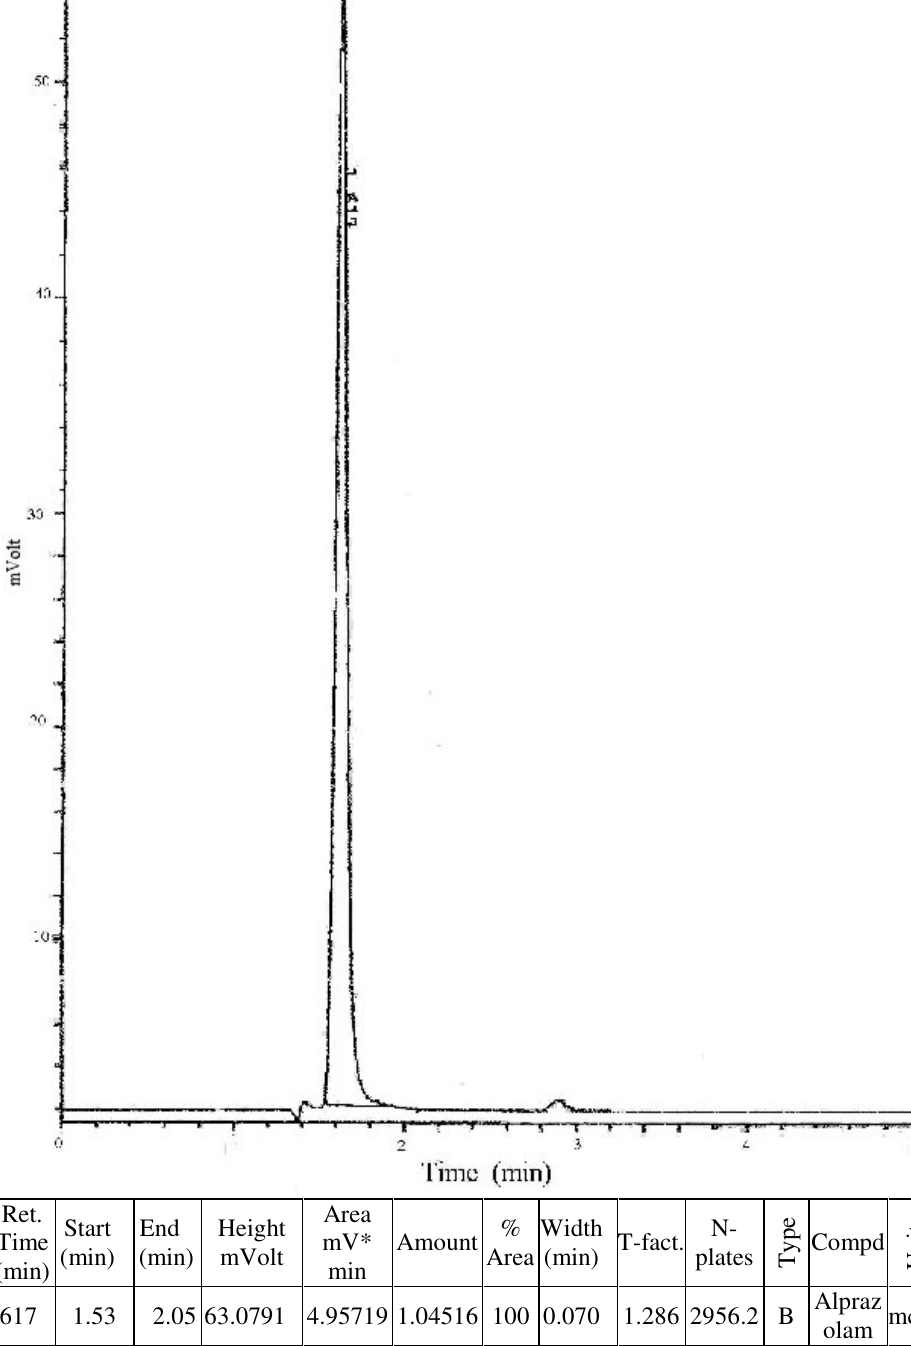
Figure 5 . HPLC Chromatogram and data peak report of alprazolam tablets active ingredient (assay) manufactured by Dr. Abidi Pharmaceutical Company of